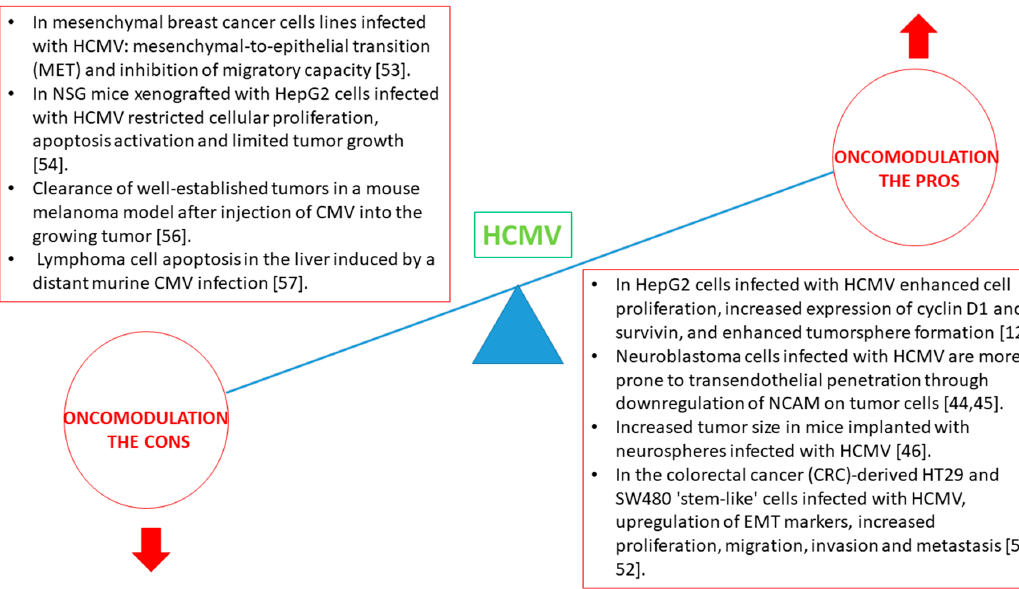
Figure 1. The pros and cons of oncomodulation following human cytomegalovirus (HCMV) infection. NSG—NOD/SCID Gamma; NCAM-Neural Cell Adhesion Molecule.